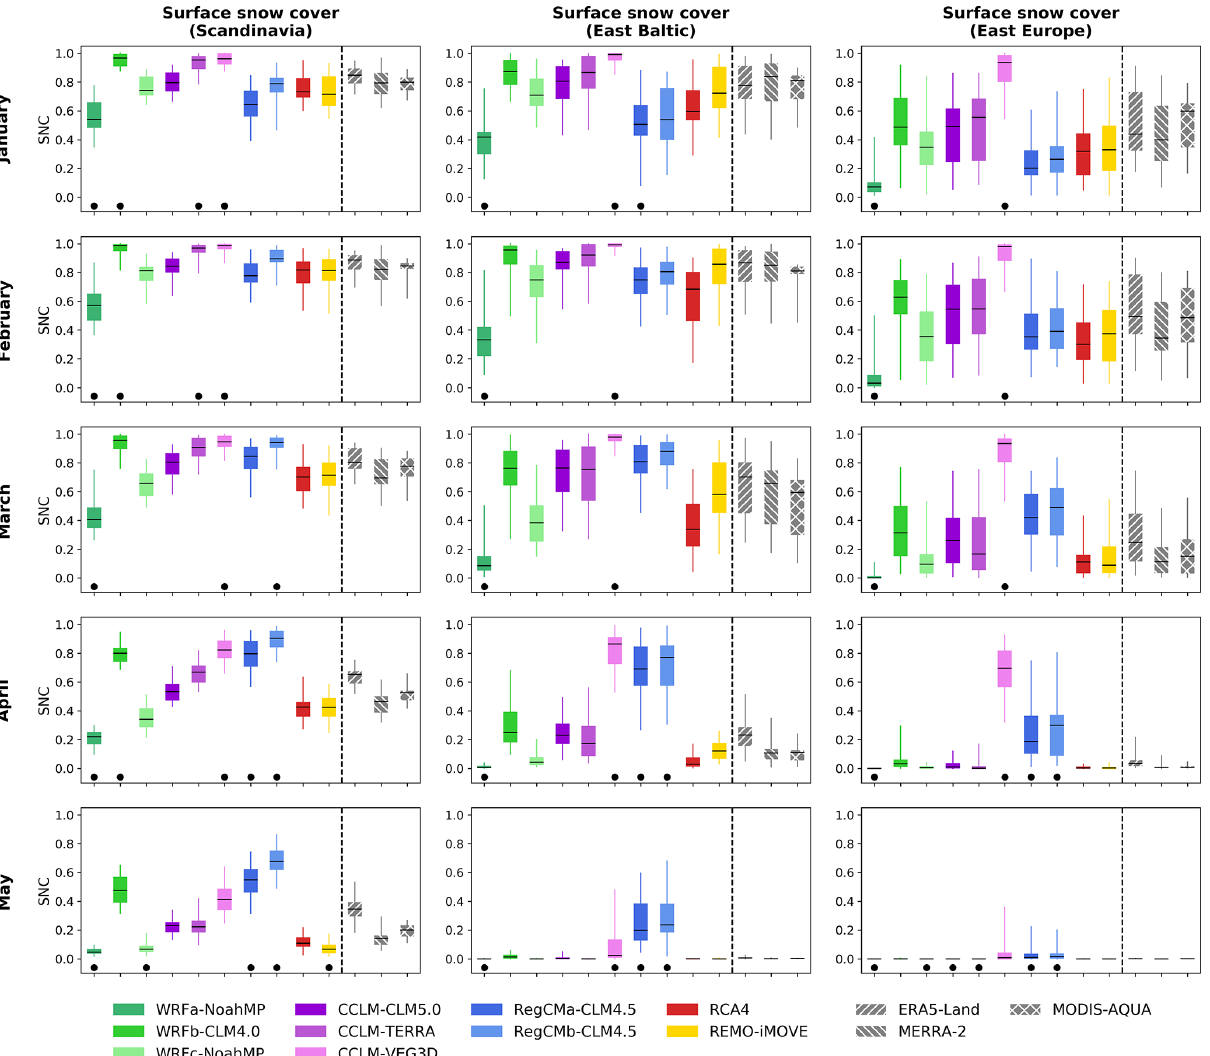
Figure 5. Snow cover for the 10 RCMs, the reanalyses of ERA5-Land and MERRA-2, and the satellite observations of MODIS-AQUA for January to May. The box-and-whisker plots show the interannual variability in snow cover over 1986–2015 for models and reanalyses and over 2003–2015 for satellite observations. Bars represent the median, boxes the interquartile range and whiskers the minimum/maximum values. Dots indicate models lying outside the range of the reference datasets of MERRA-2, ERA5-Land and MODIS-AQUA, i.e., the 25th (75th) model percentile is higher (lower) than the highest 75th (lowest 25th) quantile of the reference datasets. For satellite observations we only use data from days and pixels with less than 50% cloud cover. See Fig. S1 in the Supplement for the same figure including data for MODIS displayed for cloud cover fraction thresholds of 50% and